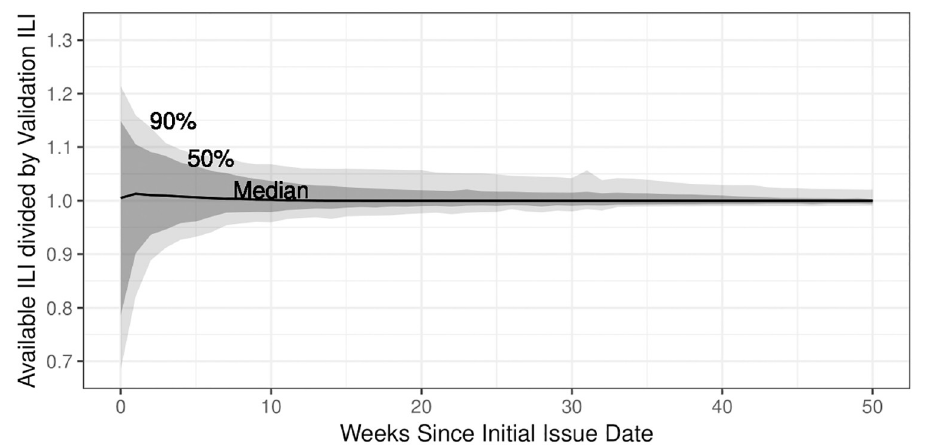
Fig 2. Changes to available ILI estimates as a function of weeks since the initial issue date, across all seasons and regions. 50% and 90% uncertainty intervals are shown. The effect of backfill diminishes as a function of weeks since the initial issue date and stabilizes after roughly 40